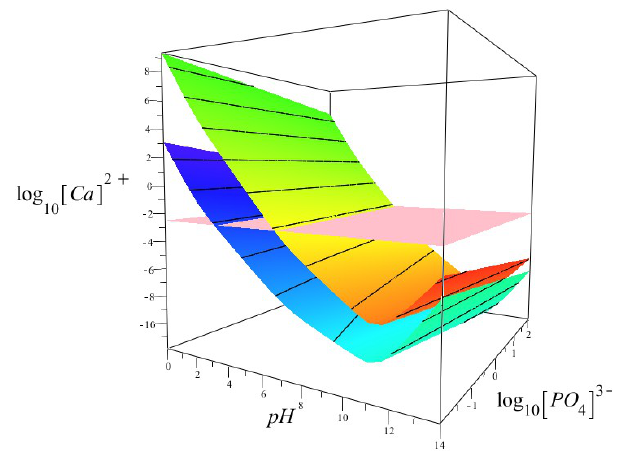
Figure 6. Solubility diagrams for the fluorapatite (lower) and hydroxylapatite (upper); the pink plane shows the average concentration of Ca 2+ ions in the physiological solution.